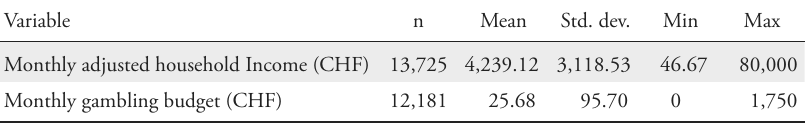
Table 1: Summary Statistics of the Suits Index Components Variable n Mean Std. dev. Min Max Monthly adjusted household Income (CHF) 13,725 4,239.12